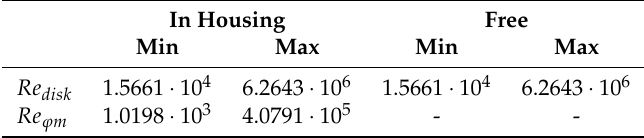
Table 4. Extreme values of the Reynolds number for the different